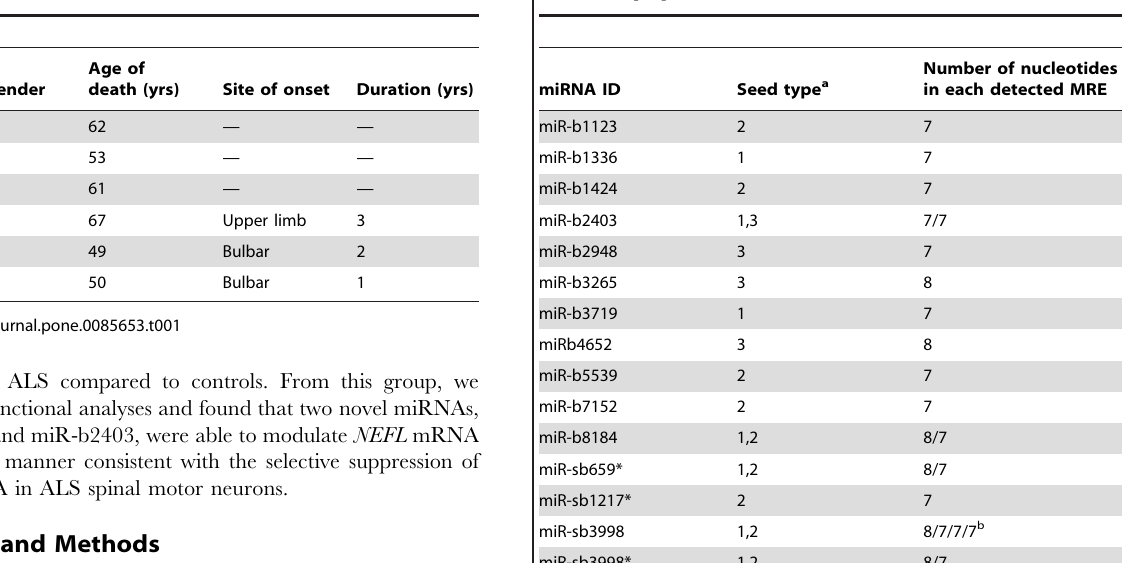
Table 1. Patient demographics of samples used in construct the small RNA libraries.